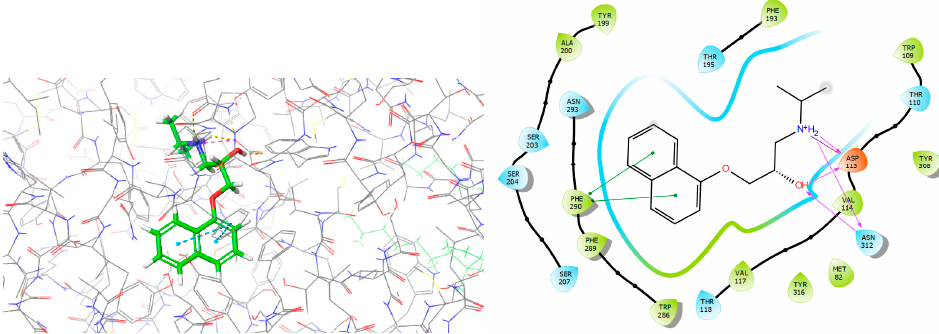
Figure 2. Complex of β 2 -adrenergic receptor with propranolol, structure from RCSB PDB, ref. code 6PS5.